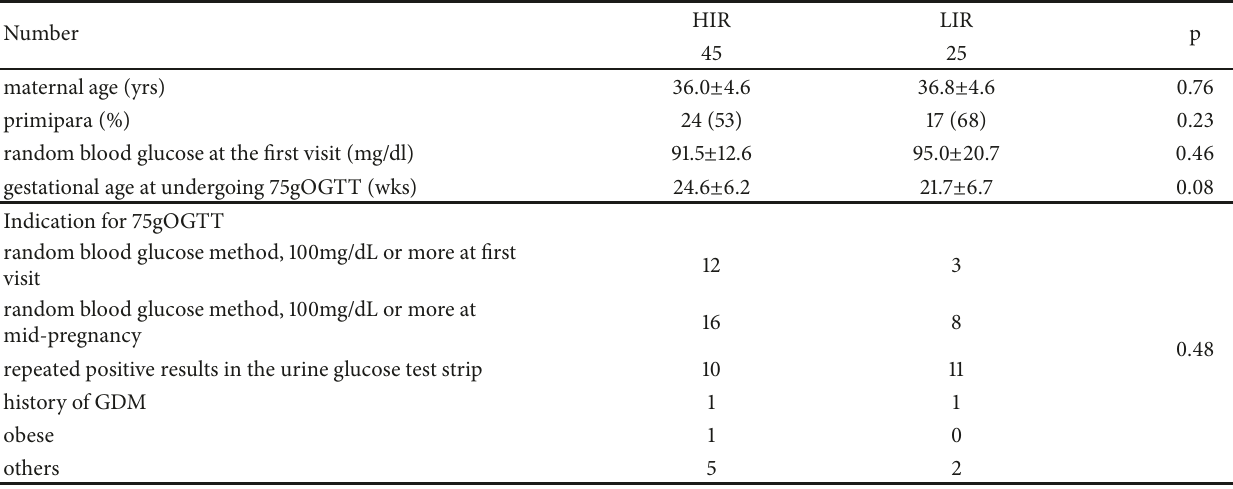
Table 1: Maternal characteristics of the LIR and HIR groups.